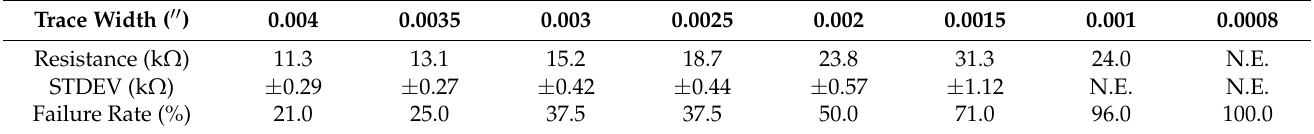
Figure 4. Trace-by-trace resistance measurement. Table 2. Failure rates at different trace widths of the coupons in Figure